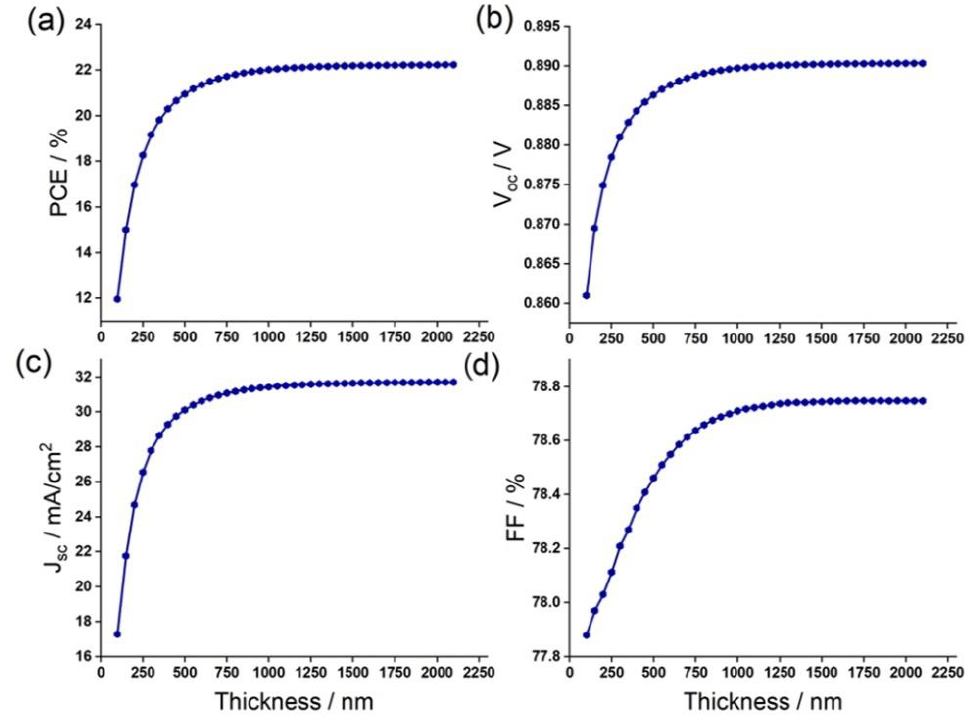
Figure 9. Change in ( a ) PCE, ( b ) V oc , ( c ) J sc and ( d ) FF against the FA 75 Cs 25 SnI 3 absorber layer thickness.